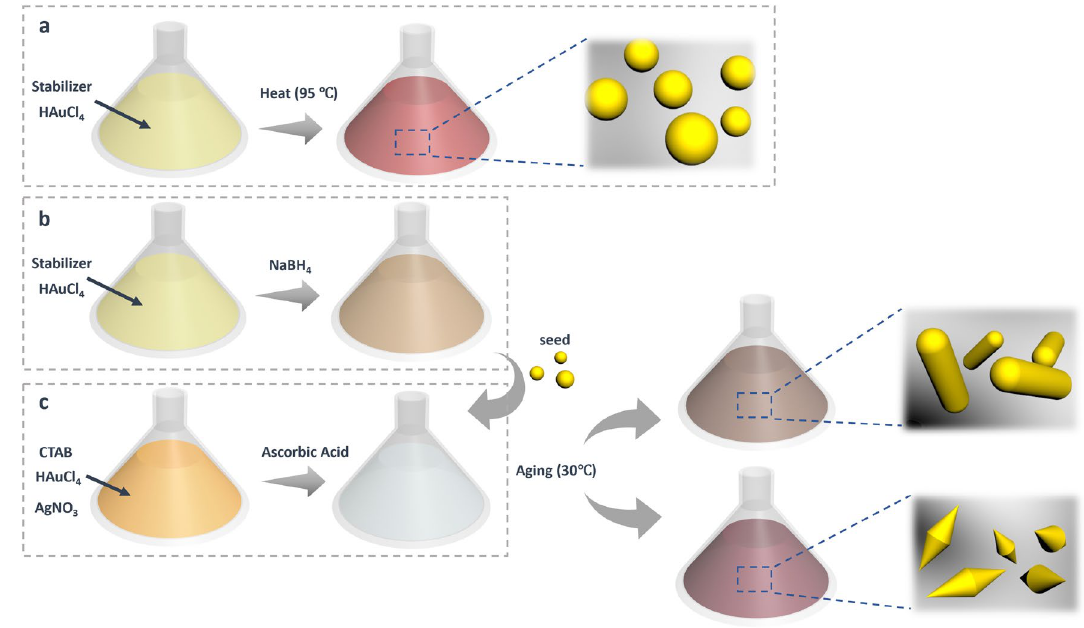
Figure 2. Nanoparticle synthesis flowchart. Gold nanospheres are fabricated by heating the mixture of Au 3+ and stabilizer. For gold nanorods and nanobipyramids, gold seeds are first generated and then mixed with plate solution. The mixture is aged overnight to obtain gold nanorods and nanobipyramids. ( a ) Synthesis flowchart of gold nanospheres. ( b ) Generation of gold seeds. ( c ) Preparation of plate